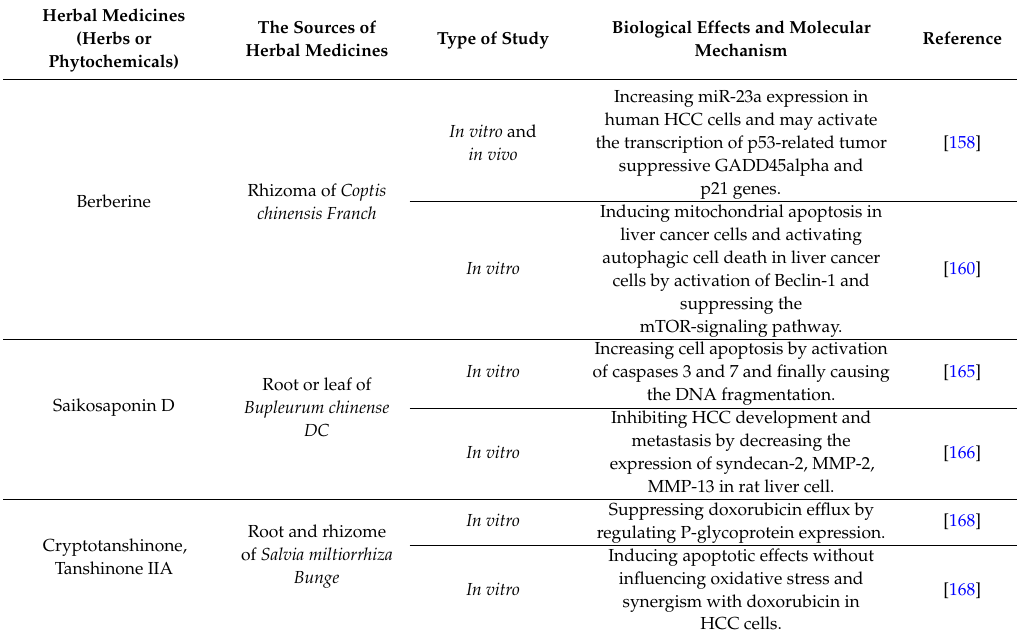
Table 4. Herbs and phytochemtableicals in primary liver cancer